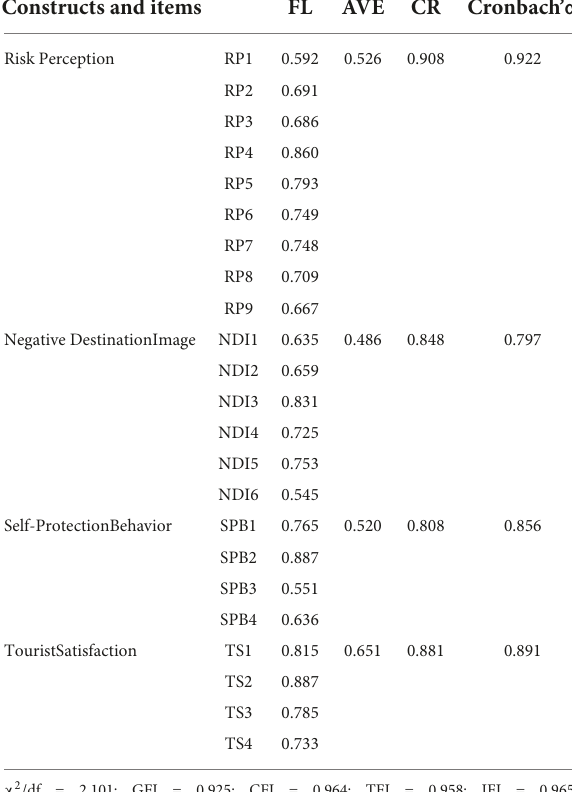
TABLE 3 Results of reliability and validity analysis.